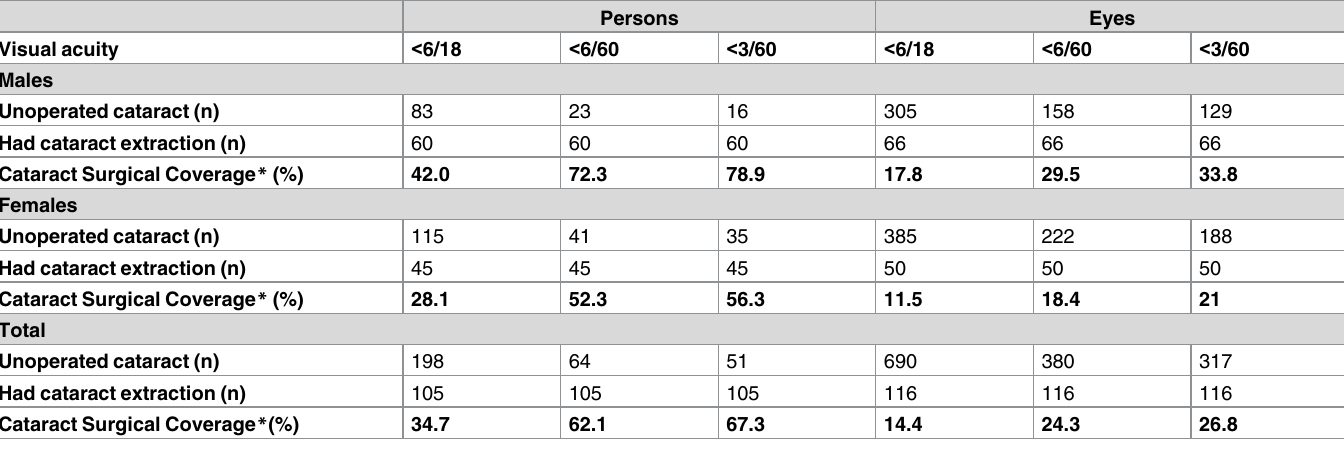
Table 3. Cataractsurgical coverage(CSC persons and eyes): Wurno health zone